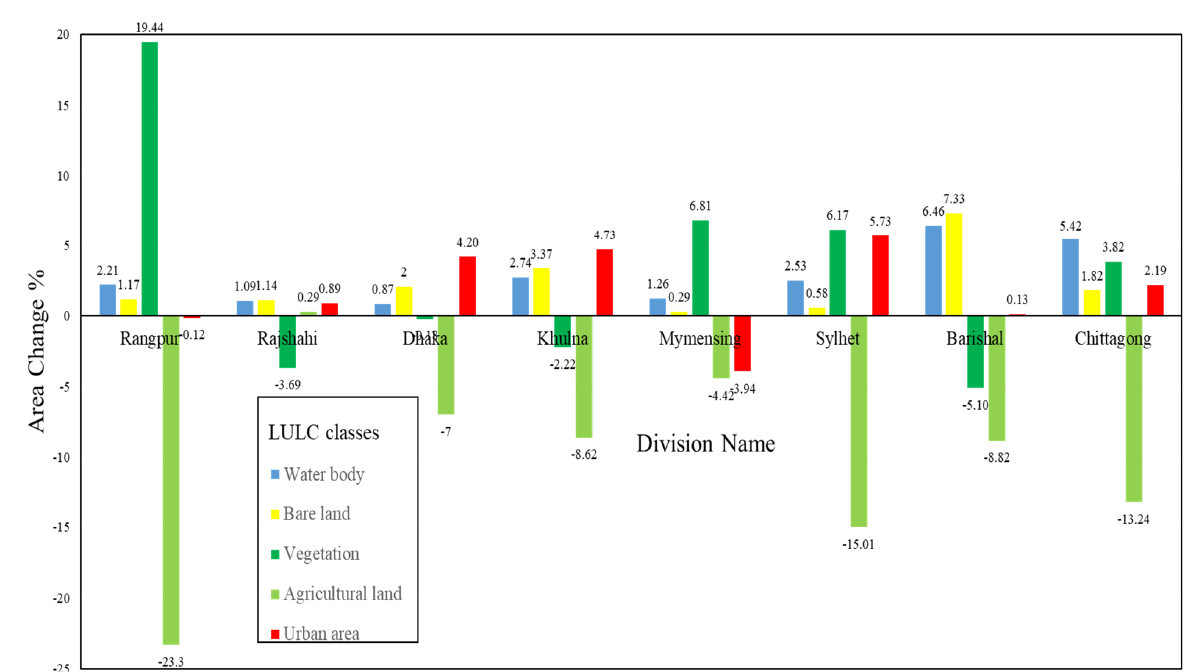
Figure 12. Administrative division wise comparison between changes of five land use land cover classes from 1995 to 2021 in the river basin of Bangladesh.